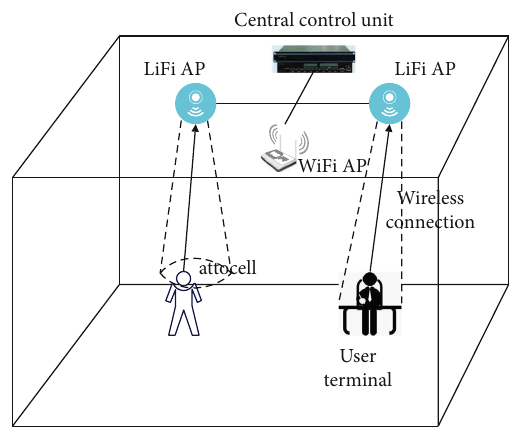
Figure 2: LiFi/WiFi hybrid network